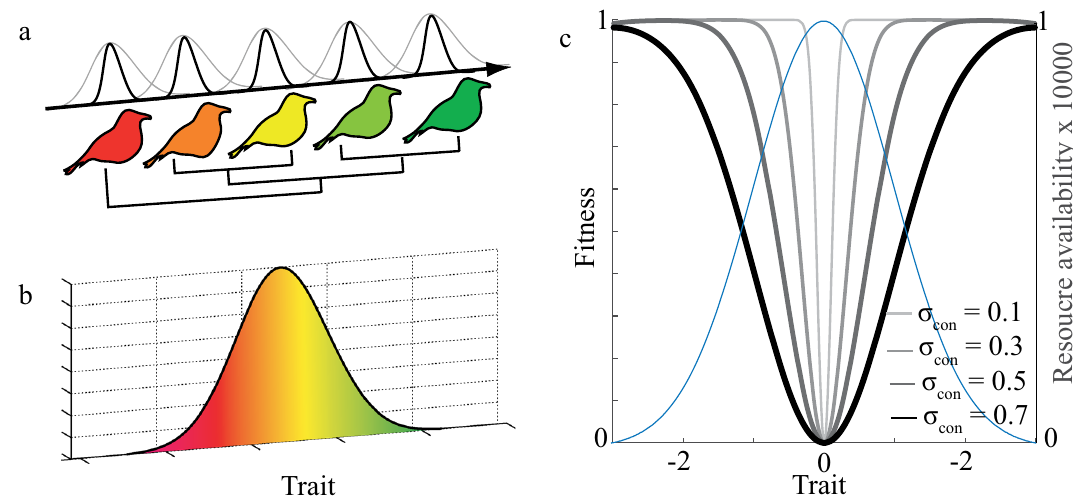
Figure 2. Model illustration ( a , b ) and fitness landscape of a mutant and/ or invading morph at the first branching point of the adaptive radiation ( c ) given different niche widths (σ con ). A local competitive community ( a ) with some trait (e.g. granivorous birds with some beak size) consumes and competes for resources locally (e.g. habitat or island). Resources are modeled as an implicit continuous resource distribution ( b ) in the same trait dimension as the resource utilization trait here illustrated by color. The fitness of a focal competitor is a function of its trait-matching to its resources, the traits of its competitors, and their niche widths (black and gray niche kernels). If the niche width of the competitors is wide (grey niche kernels) competition strength will be higher in the system than if the niche widths are narrow (black niche kernels). Panel c illustrates resource (blue line) dependent mutant and/ or invader fitness (first y-axis) as a function of trait value (x-axis) with a resident population with trait value = 0 at ecological equilibrium. The seeded monomorphic population (trait value = 0) thus sits on a fitness minimum (branching point) and at equilibrium abundance, the curvature of the fitness landscape and thus the strength of disruptive selection is dependent on niche width (σ con ) ( c ). The blue line in c denotes resource distribution (second y-axis) as a function of organismal trait (x-axis). Model parameters that were kept constant to compute the fitness landscapes were: K 0 = 10,000; σ K = 1; r = 1; µ = 0.01; σ µ = 0.02. Figure produced in Adobe Illustrator CS6 Version 16.0.0 and MATLAB version